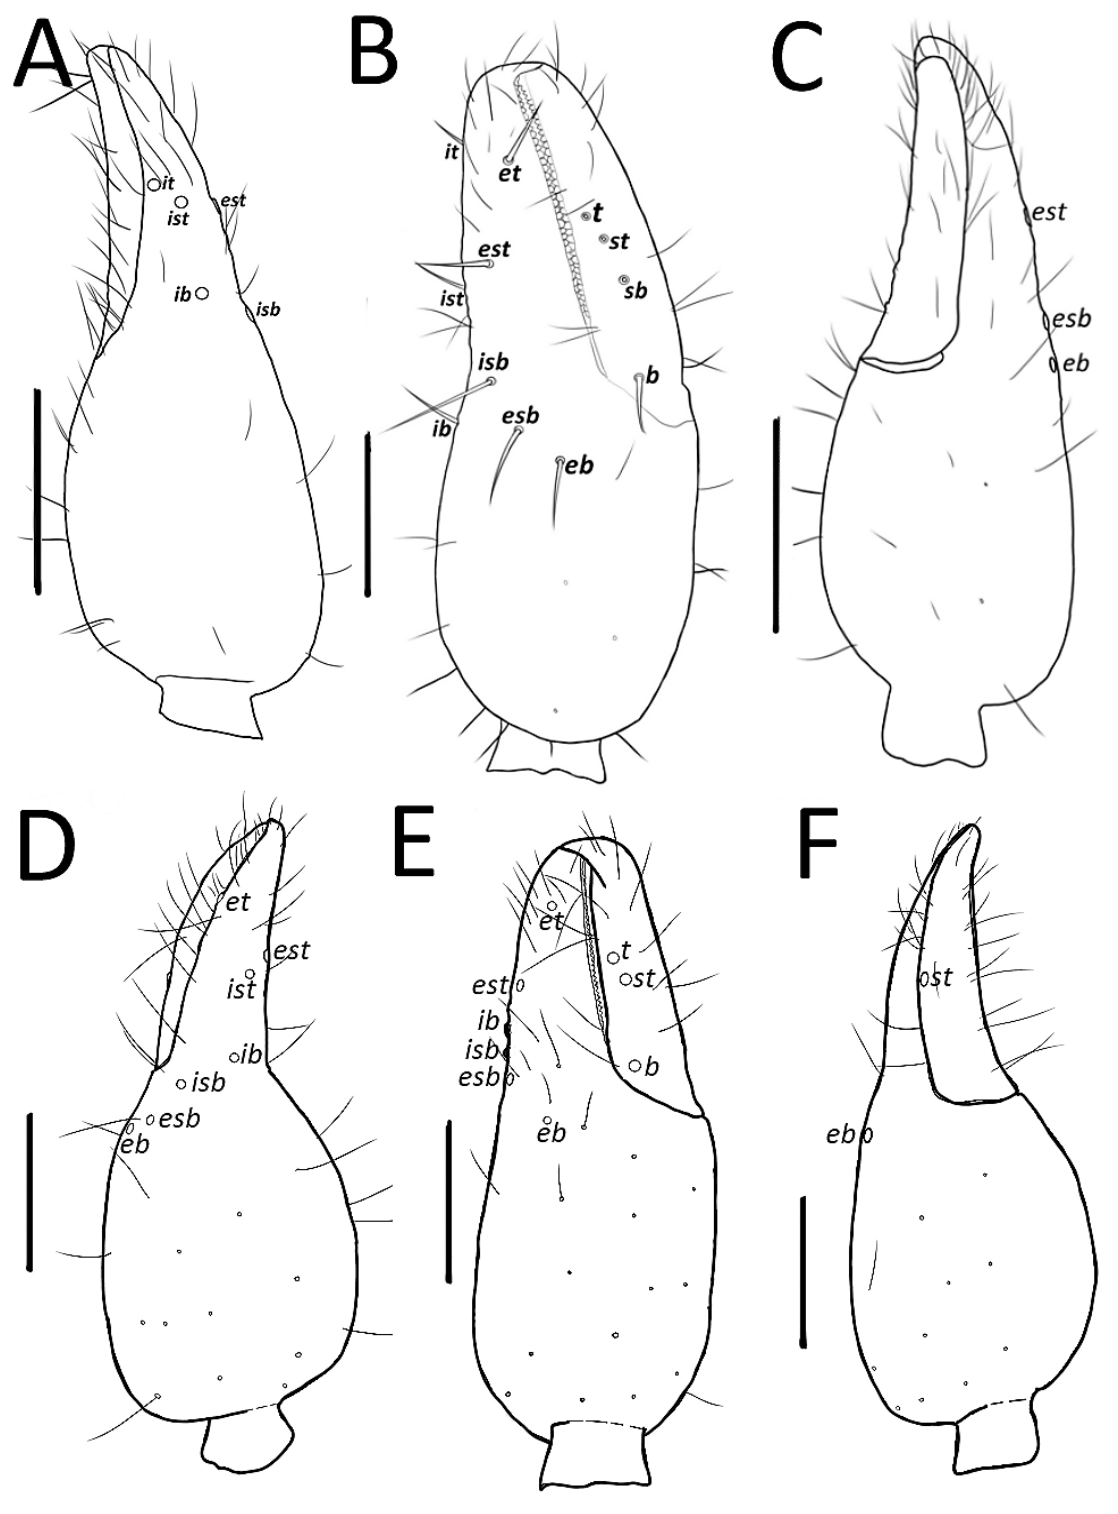
Fig. 30. Ideoblothrus safinai sp. nov. A . Chela in dorsal view, with trichobothria. B . Chela in retrolateral view. C . Chela in ventral view. D . Chela in dorsal view, showing position of trichobothria. E . Chela in retrolateral view. F . Chela in ventral view. A–C: holotype, ♂ (QCAZ); D–F: tritonymph (ZMH A0015396). Scale bars: 0.25